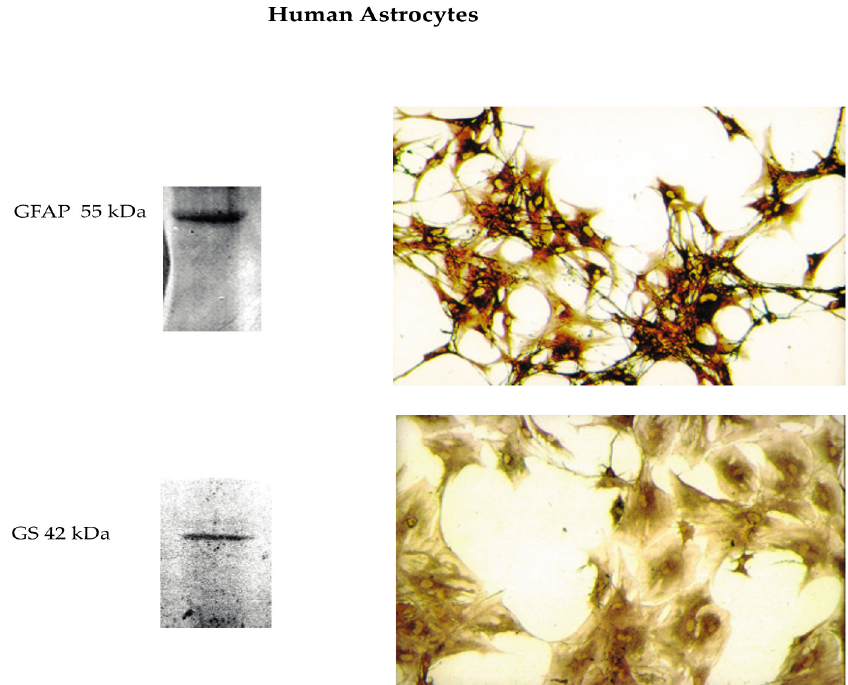
Figure 1. Pictures of pure (100%) in vitro cultures of cortical nontumorigenic adult human astrocytes (NAHAs) that express their cell type-specific markers glial fibrillary acid protein (GFAP) (top panels) and glutamine synthase (GS) (bottom panels) as detected in immunoblots (left panels) and via immunocytochemistry (right panels). NAHAs cultures were set up as detailed in the Materials and Methods). After two weeks of staying in vitro, they were sampled and processed for western immunoblotting and immunocytochemistry as described in the Materials and Methods. Original magnification of the microscope pictures: GFAP, X 100; GS, X 200.